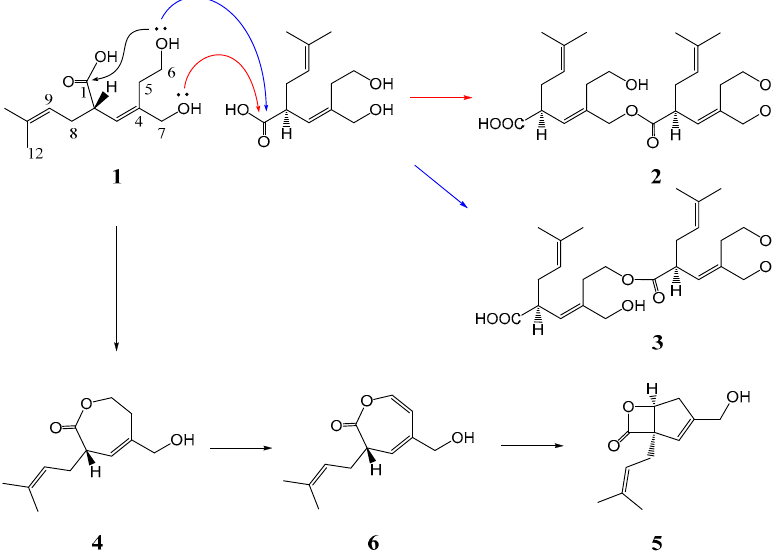
Figure 5. 1 H chemical-shift differences ( Δ δ ppm) between the ( S )- and ( R )- PGME amides 1a and 1b .